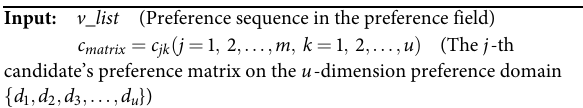
Algorithm 3 Affecter algorithm Algorithm 4 Decider algorithm